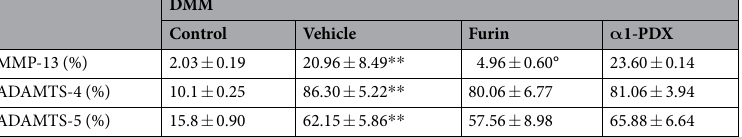
Table 1. Number of protease expressing cells in articular cartilage of mice treated with Furin or antagonist α 1-PDX. The number of cells expressing MMP-13, ADAMTS-4 or ADAMTS-5 was revealed